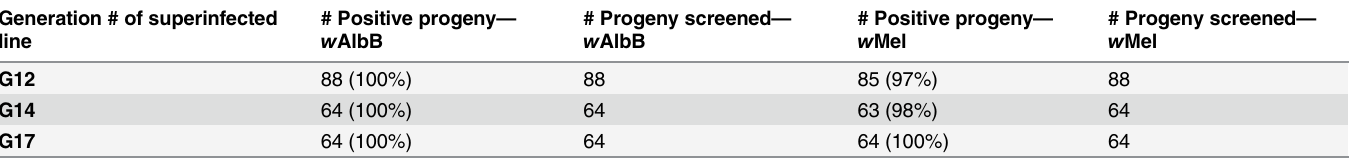
Females of the superinfected line at G12, G14 and G17 were crossed to wild type males and their progeny were screened for the presence of w AlbB and w Mel by qPCR.